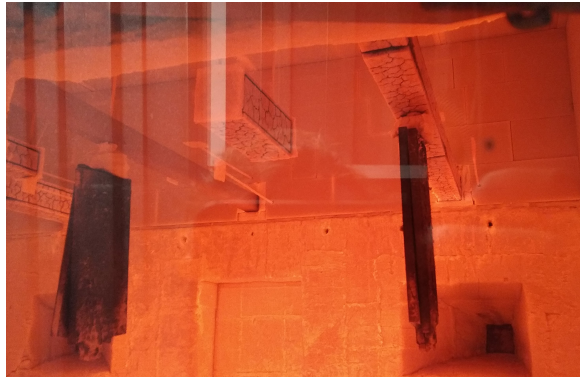
Figure 1. Beams in the furnace during the experiment.